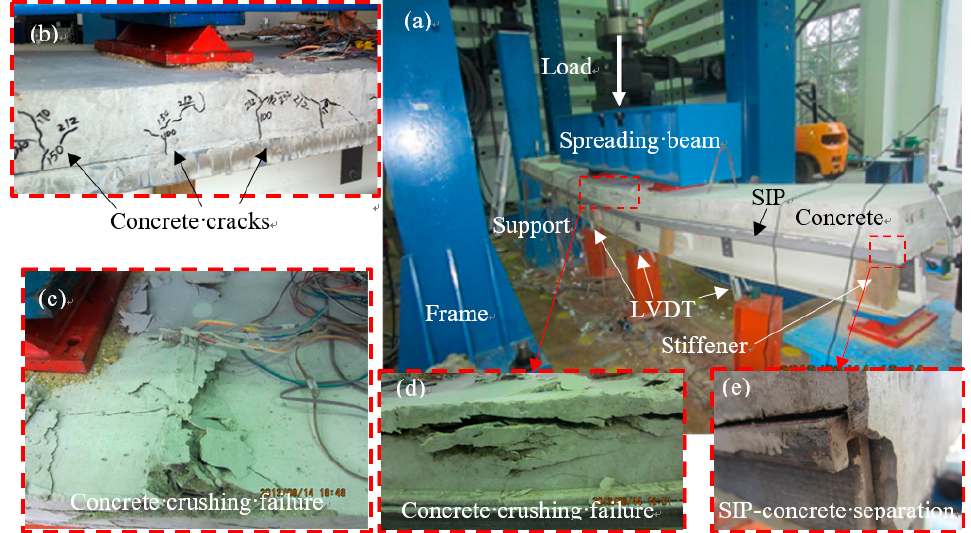
Figure 5. Failure mode for Beam 2. ( a ) Loading of beam 2; ( b ) Concrete cracks beneath the loading point; ( c ) Mid-span concrete crushing (from top view); ( d ) Mid-span concrete crushing (from side view); and ( e ) The slip and separation of the SIP-concrete interface at the beam end.